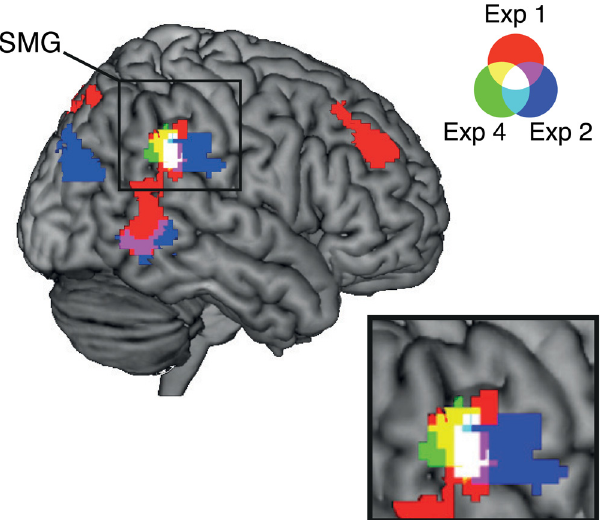
Fig 9. Overlaps of clusters showing a duration adaptation effect during the time task across experiments. Colors correspond to the results of each experiment: red for experiment 1, blue for experiment 2, and green for experiment 4. Overlapped areas show mixed colors, as shown in the legend. The clusters in the SMG are magnified at the bottom